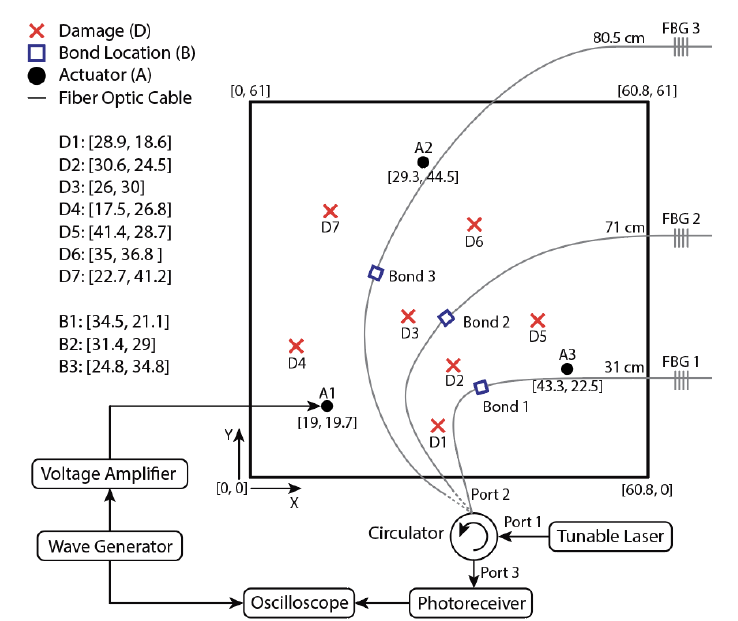
Figure 4. Schematic of the experimental setup (Coordinates are in cm).